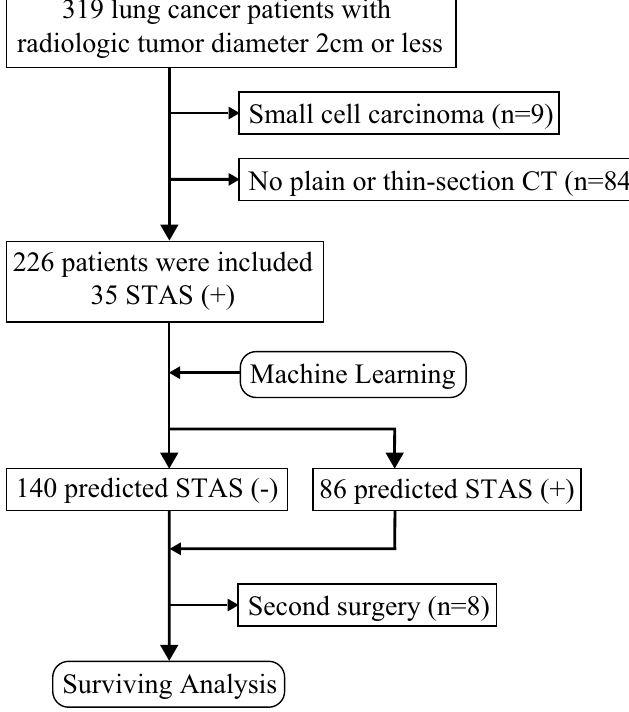
Figure 1. Study cohort flow chart. Peripheral tumors ≤ 2 cm in size on computed tomography that were potential candidates for sublobar resection were enrolled. Four of the patients included in the analysis predicting STAS underwent surgery 2 times during the period. Therefore, the survival curves were analyzed excluding those